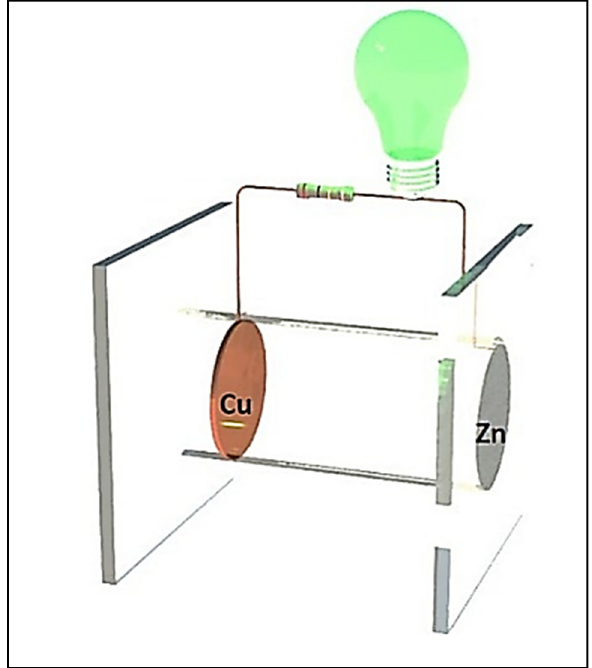
Figure 1. Microbial fuel cell prototype.